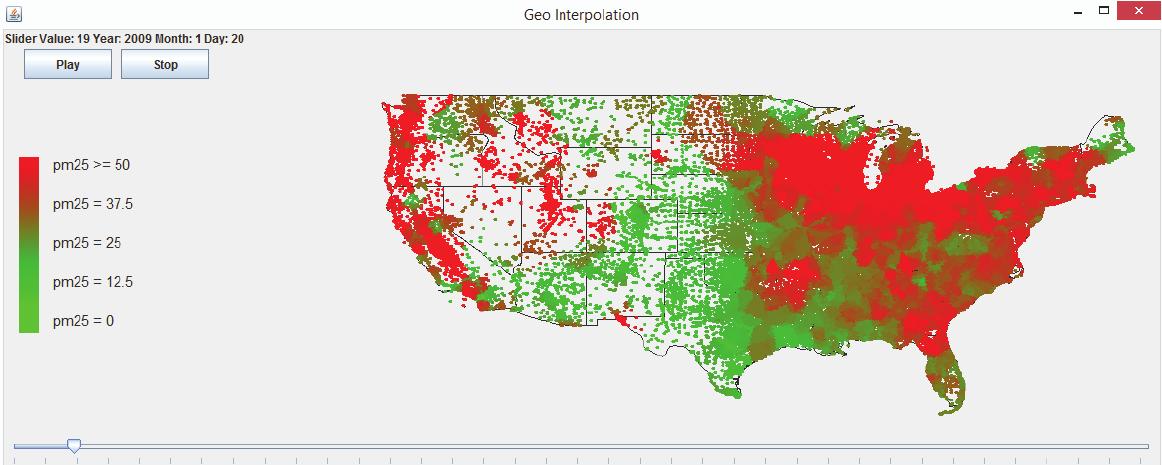
Figure 24. Interpolated PM visualization map for centroids of census block groups in the 2 : 5 contiguous U.S. on 20 January 2009.